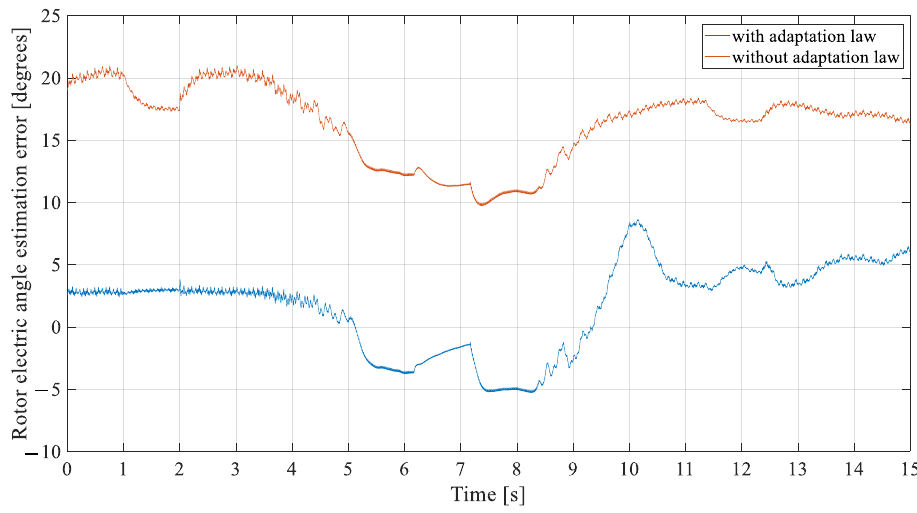
Figure 5. Behavior of the reference and actual rotor axes currents in the whole test.